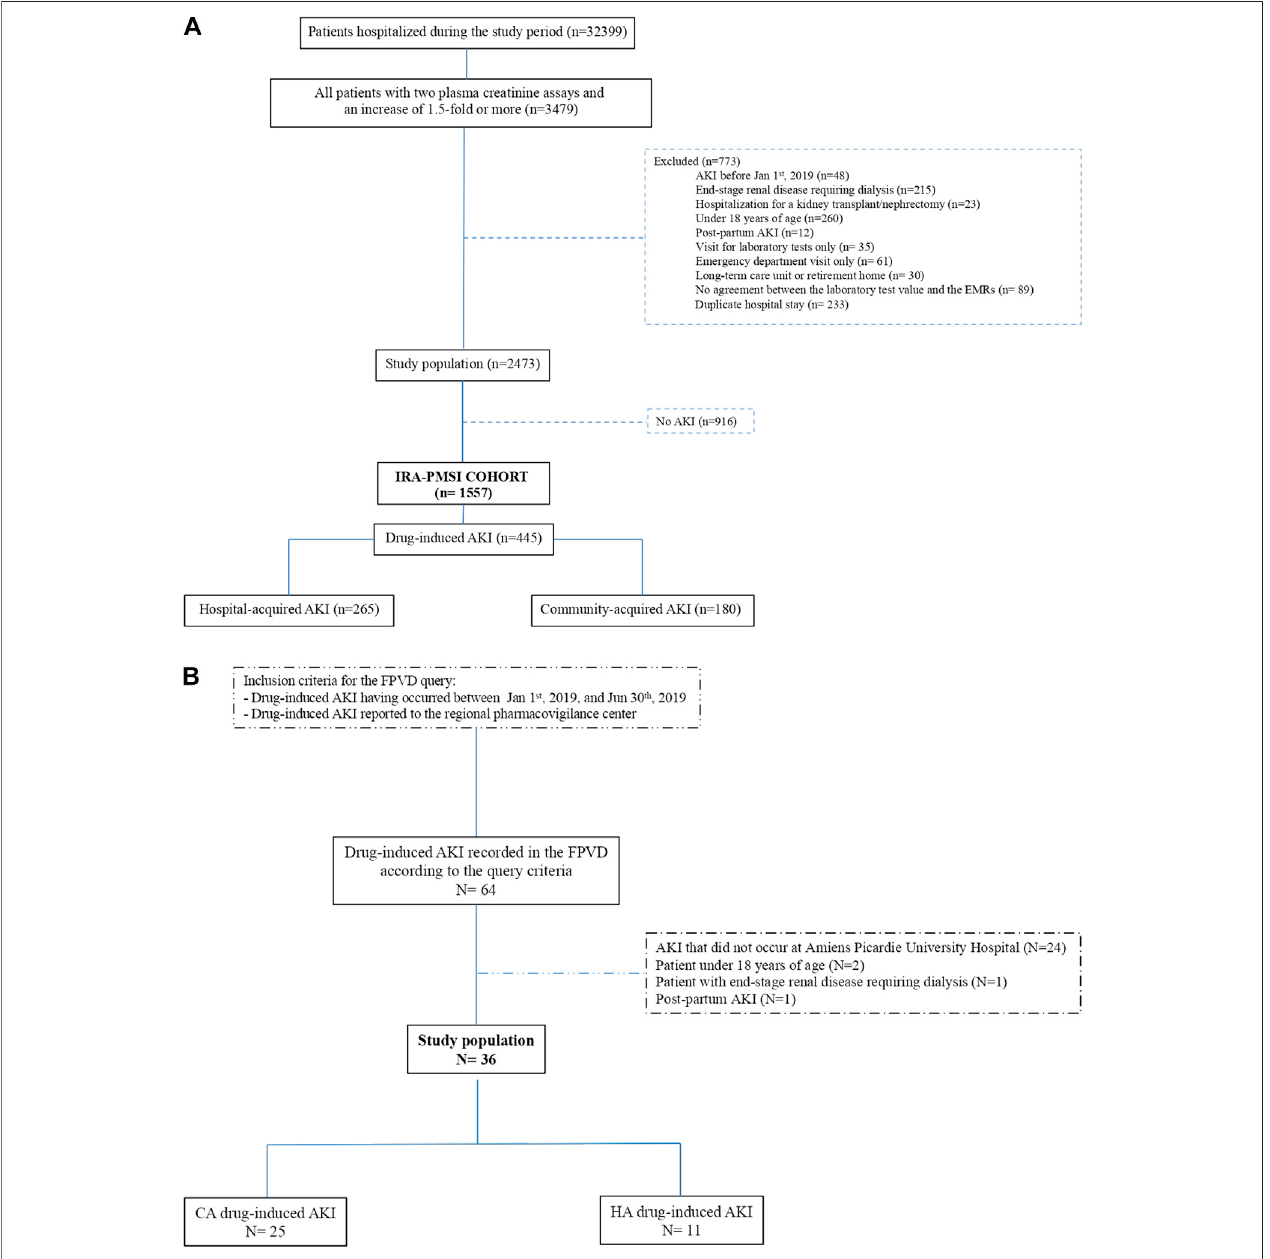
FIGURE 2 | (A) Flow chart for the “ IRA-PMSI ” cohort, with the selection of drug-induced AKIs only (Rey et al., 2021). AKI, acute kidney injury; EMR, electronic medical record; PMSI, Programme de Médicalisation des Systèmes d ’ Information (the French national hospital discharge database). (B) Flow chart for the FPVD query. AKI, acute kidney injury; CA, community-acquired; HA, hospital-acquired; FPVD, French national pharmacovigilance database.